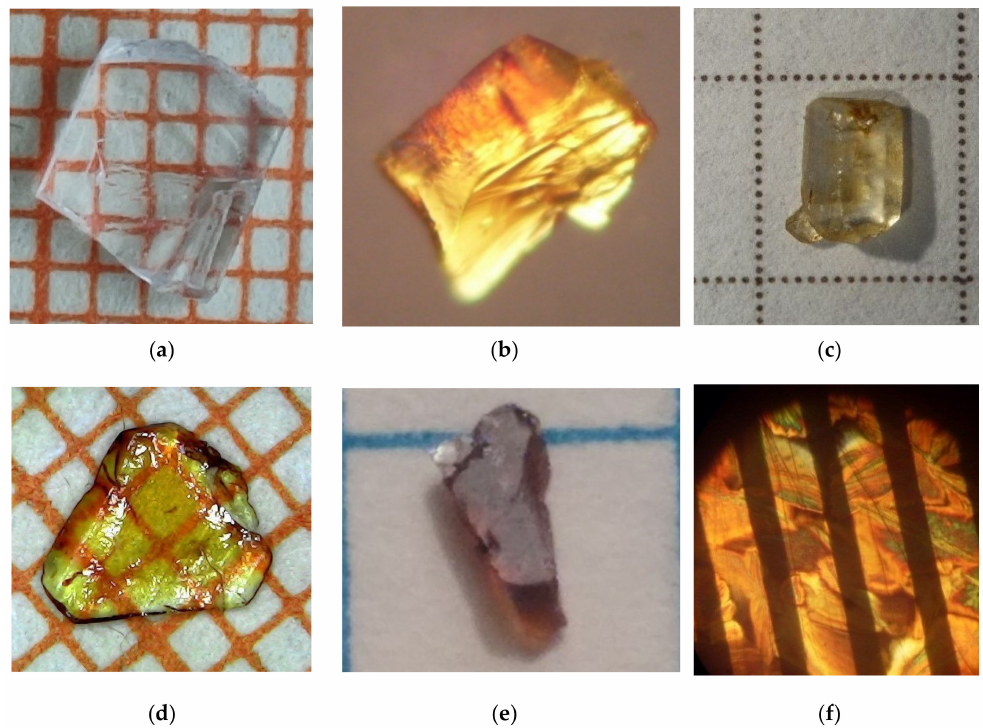
Figure 1. Images of ( a ) TGS and ( b ) CA crystals used for the growth of TGS:CA crystals and films. ( c ) TGS:CA crystals grown from aqueous solution of TGS and CA (TGS:CA (98:2), ( d ) TGS:CA (90:10), ( e ) TGS:CA (80:20)). ( f ) TGS:CA (80:20) film grown by evaporation on α -Al 2 O 3 substrate with an interdigital system of electrodes. Black bands in ( f ) are the regions between gold electrodes. The distance between electrodes ≈ 40 µ